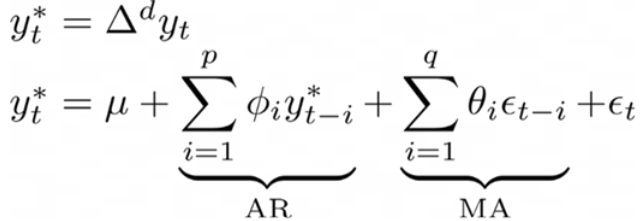
Figure 4. ARIMA model: ARIMA ( p , d , q ) represents an autoregressive moving average model for integrated time series where [68] p is the order of the autoregressive component, d is the level of integration of the time series, q is the order of the component of the moving averages [68]. The results indicate that all established model fitting parameters were suitable for further drawing graphs and forecasting the overnight trend for the next two years: E = 6442.125, S.E = 1830.390. t = 3.520, p = 0.01.